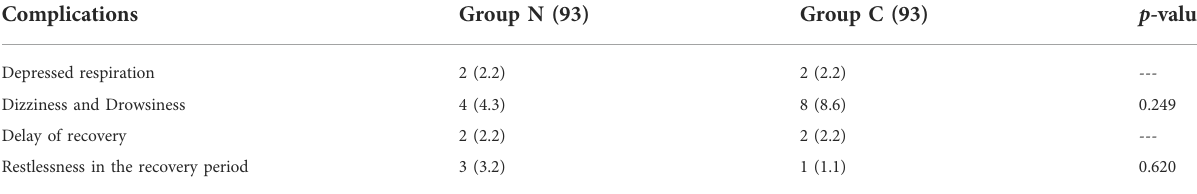
TABLE 4 Comparison of adverse reactions during the recovery period between the two groups (n (%)).